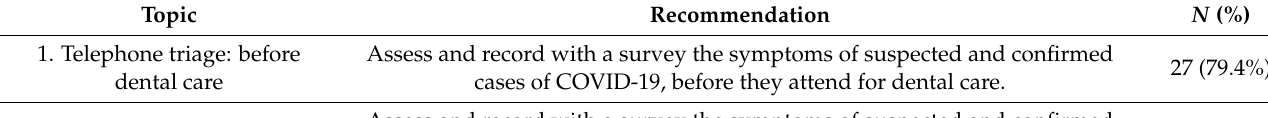
Table 2. Telephone triage, in-person triage, and general recommendations for the patients. Topic